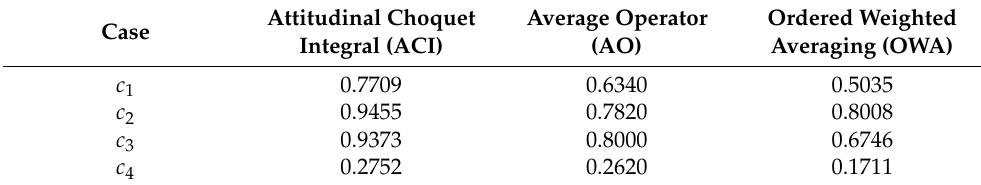
Table 12. Global similarity under different aggregation